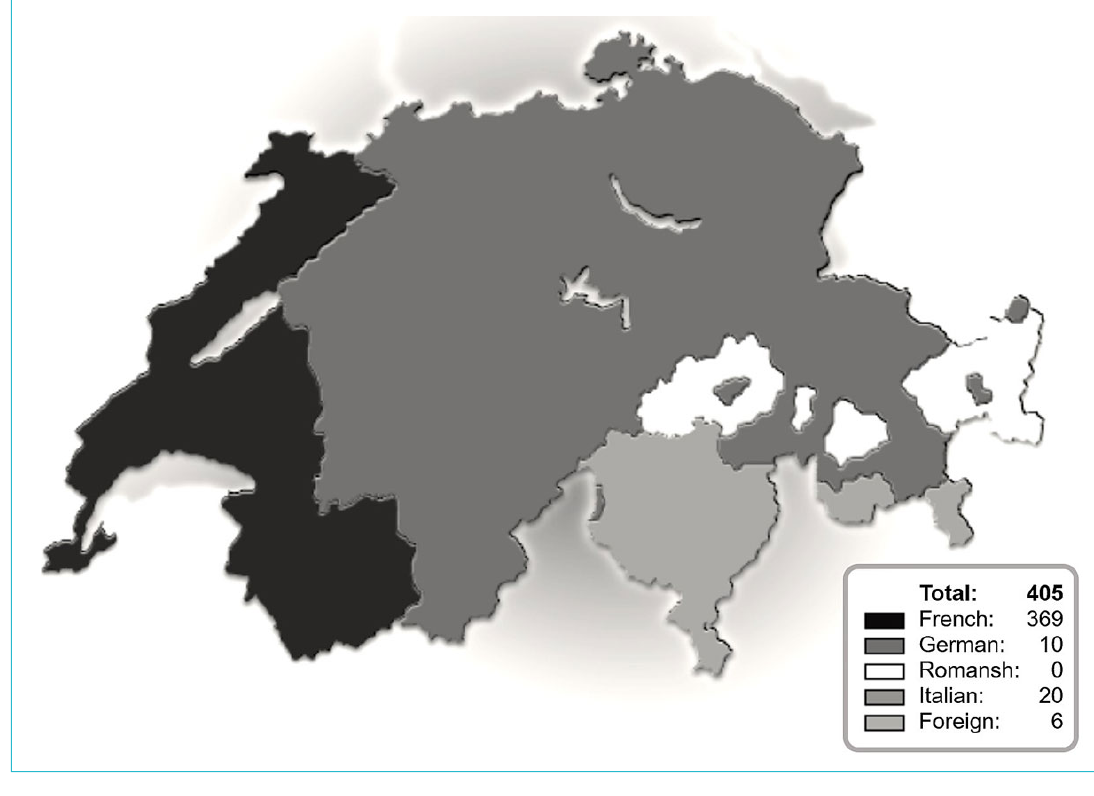
Figure 1: Numbers and origins of requests at the Swiss regional centre for trophoblastic disease.